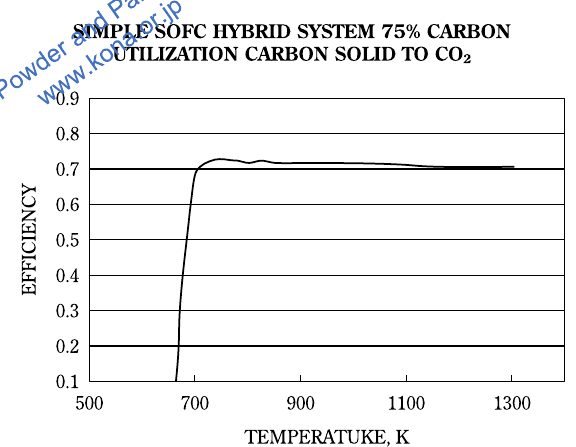
Fig. 3 Projection of DCFC Thermal Efficiency in a Simple SOFC Hybrid System